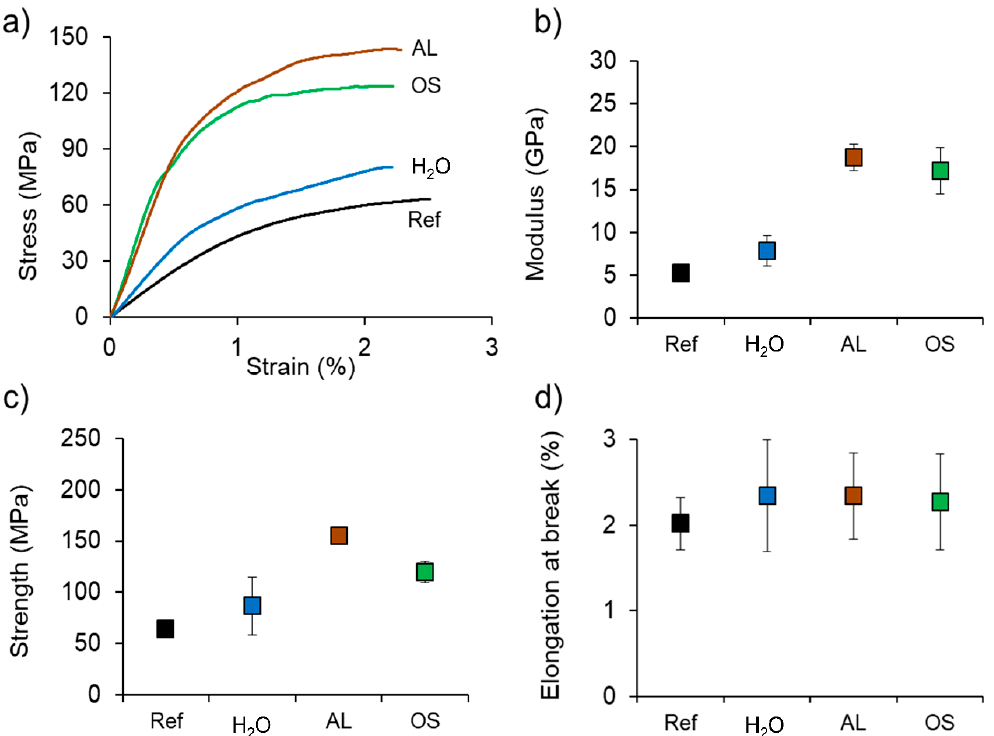
Figure 5. Mechanical characterization of plywood samples made of reference (Ref), densified water- soaked (H 2 O), densified alkali-treated (AL) and densified organosolv-treated (OS) spruce veneers conditioned at 20 °C and 65% relative humidity by longitudinal bending tests: ( a ) Representative stress-strain curves for each treatment; ( b ) Elastic Modulus; ( c ) Strength; ( d ) Elongation at break. ( n = 8 for Ref; n = 8 for H 2 O; n = 8 for AL; n = 8 for OS).